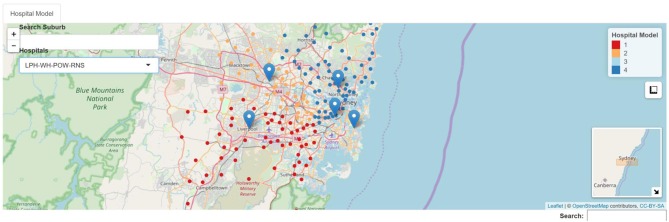
Example of 4 hospital model. RNS, Royal North Shore Hospital, blue; LPH, Liverpool Hospital, red; WH, Westmead Hospital, orange, POW, Prince of Wales Hospital, light blue.